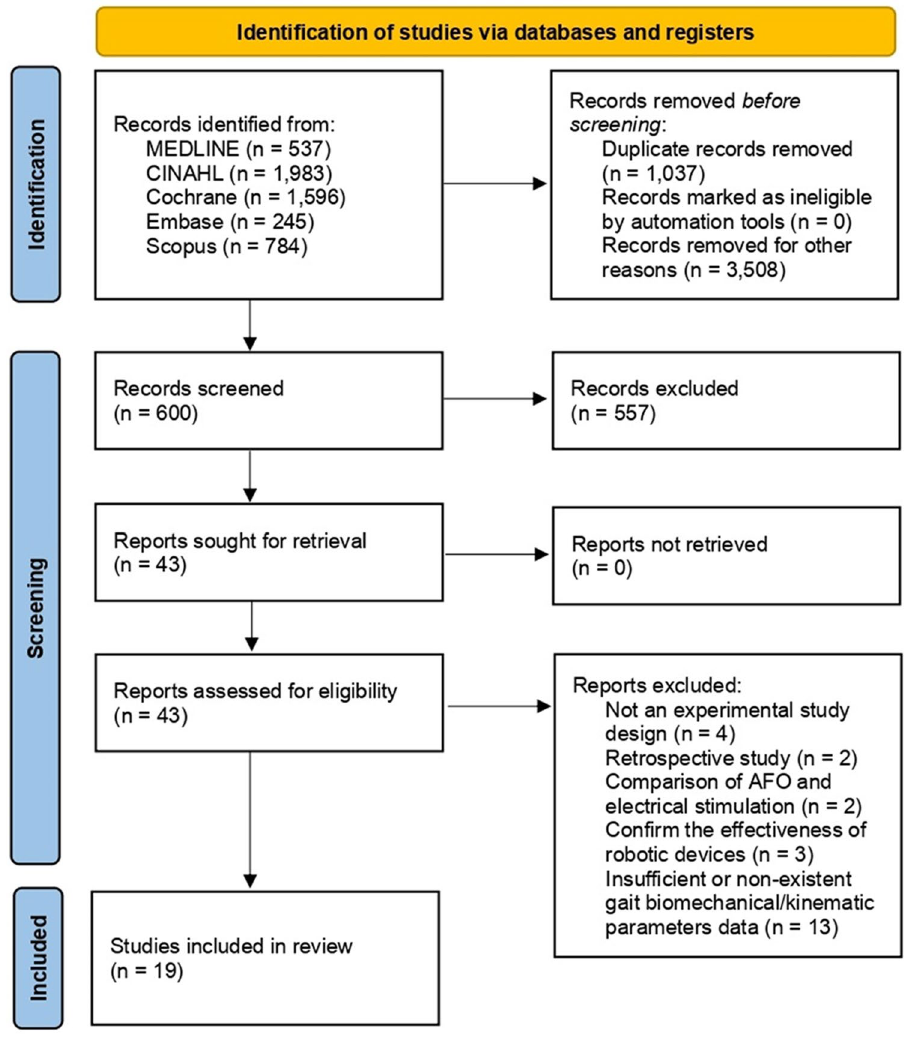
Figure 1. Flowchart showing the search results of the